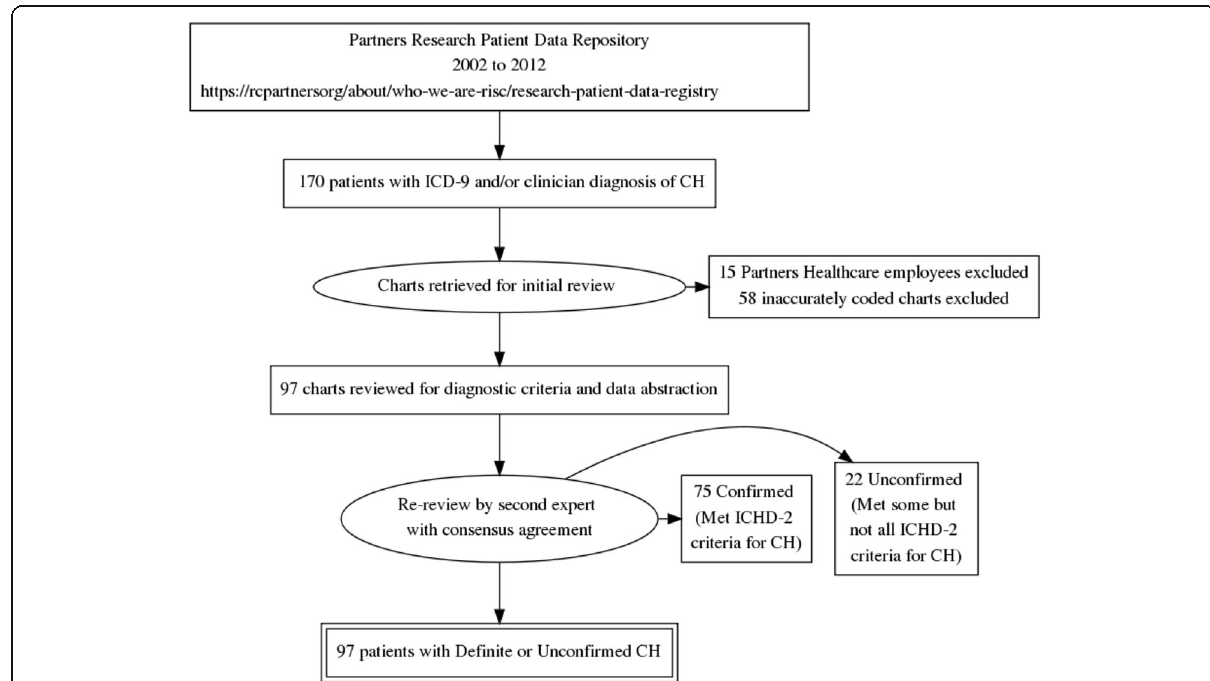
Fig. 1 Flow of patients through the study. Abbreviations: ICD = International Classification of Diseases; ICHD-2 = International Classification of Headache Disorders, 2nd edition; CH = Cluster